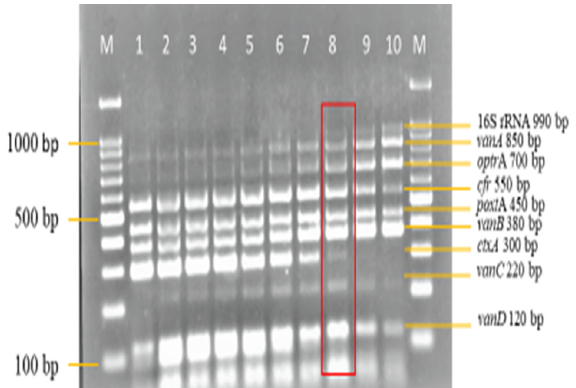
Figure 7. Annealing temperature optimization in the multiplex PCR. An annealing temperature of 64.5 °C on lane 8 from a range of temperature set (58–65.8 °C) was selected as the optimum annealing temperature. Lane M: DNA ladder 100 bp plus. Lane 1: 58 °C. Lane 2: 58.7 °C. Lane 3: 59.5 °C. Lane 4: 60.5 °C. Lane 5: 61.5 °C. Lane 6: 62.5 °C. Lane 7: 63.5 °C. Lane 8: 64.5 °C. Lane 9: 65.3 °C. Lane 10: